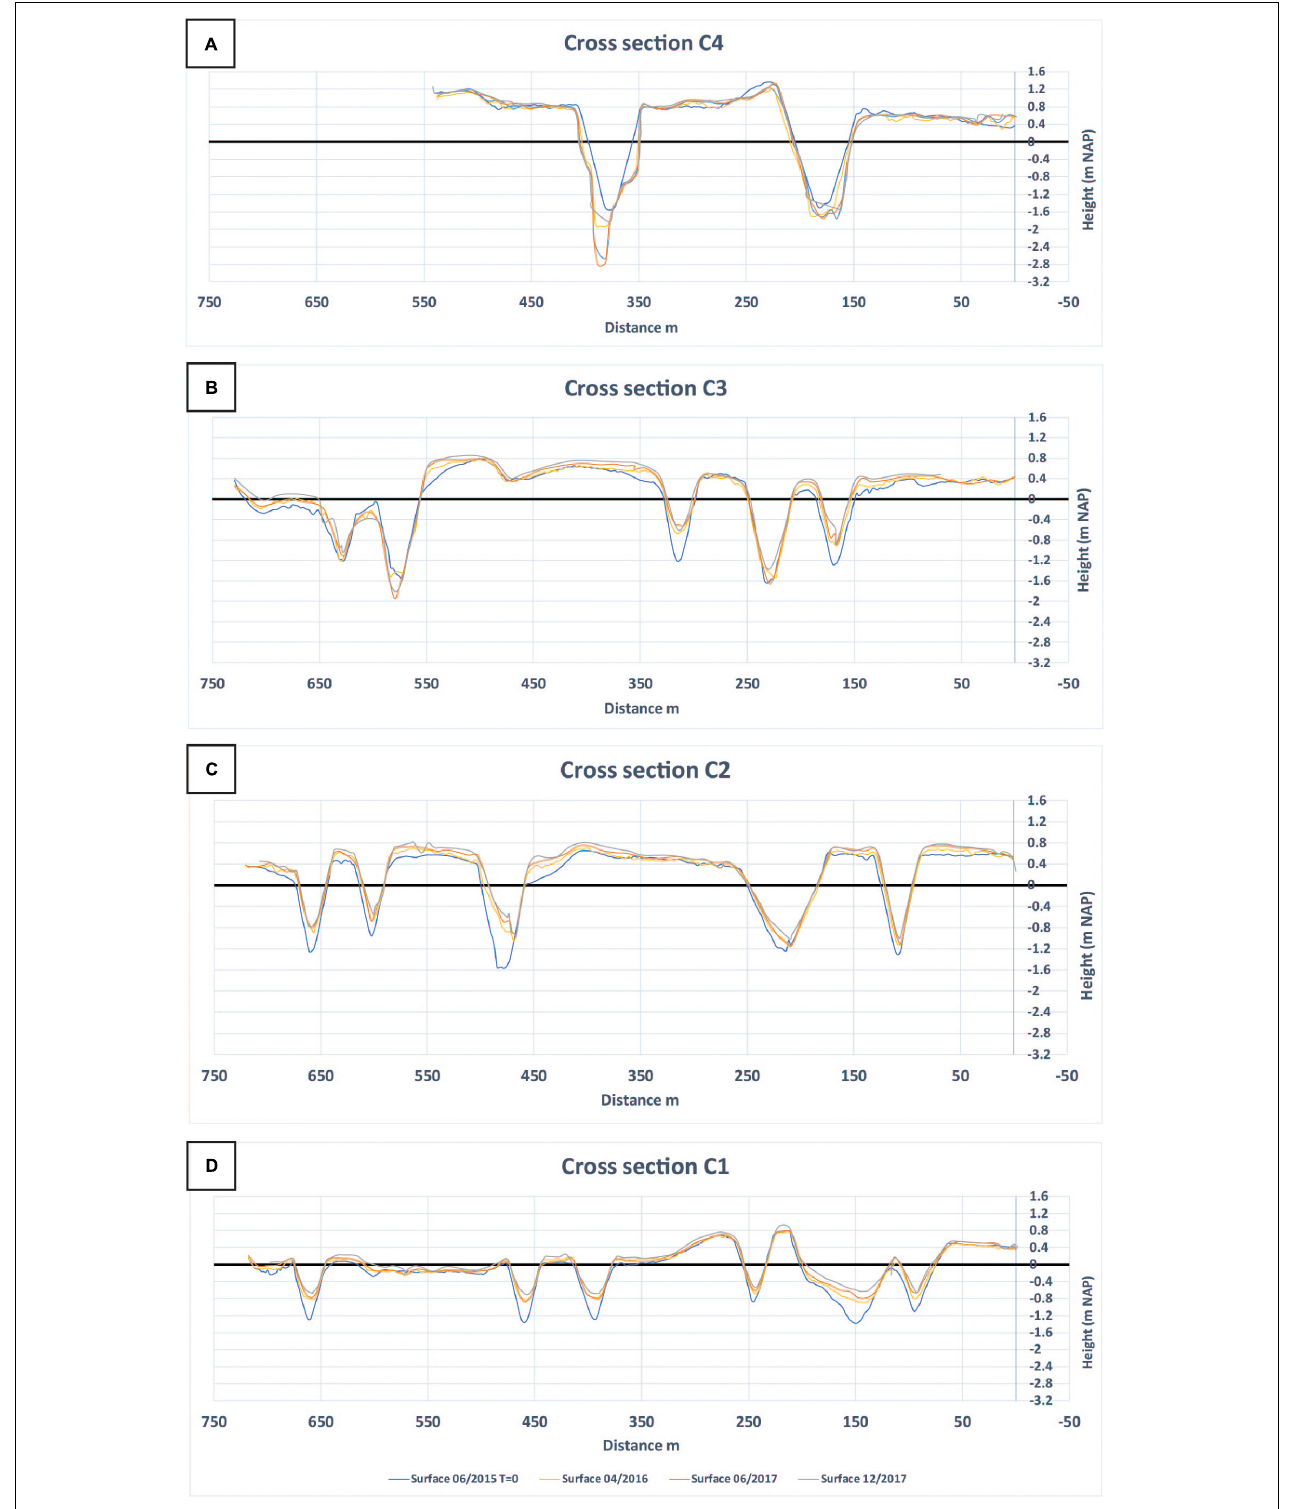
FIGURE 5 | Cross sections from North to South (A) C4, (B) C3, (C) C2, (D) C1 extracted from Lidars (2015 and 2016) and from DGPS surveys (June and December 2017). To notice that in the graphs the survey of June 2017 is presented (orange line) to qualitatively assess bed changes but this was not used for volume calculations as it was too close in time with the preceding and subsequent